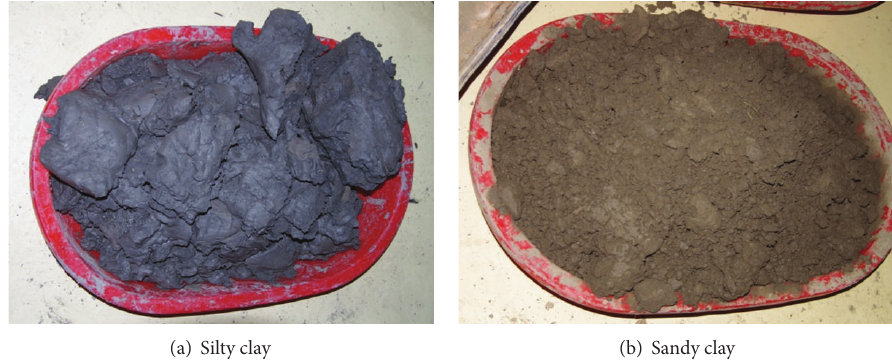
Figure 4: Pictures of soil samples.